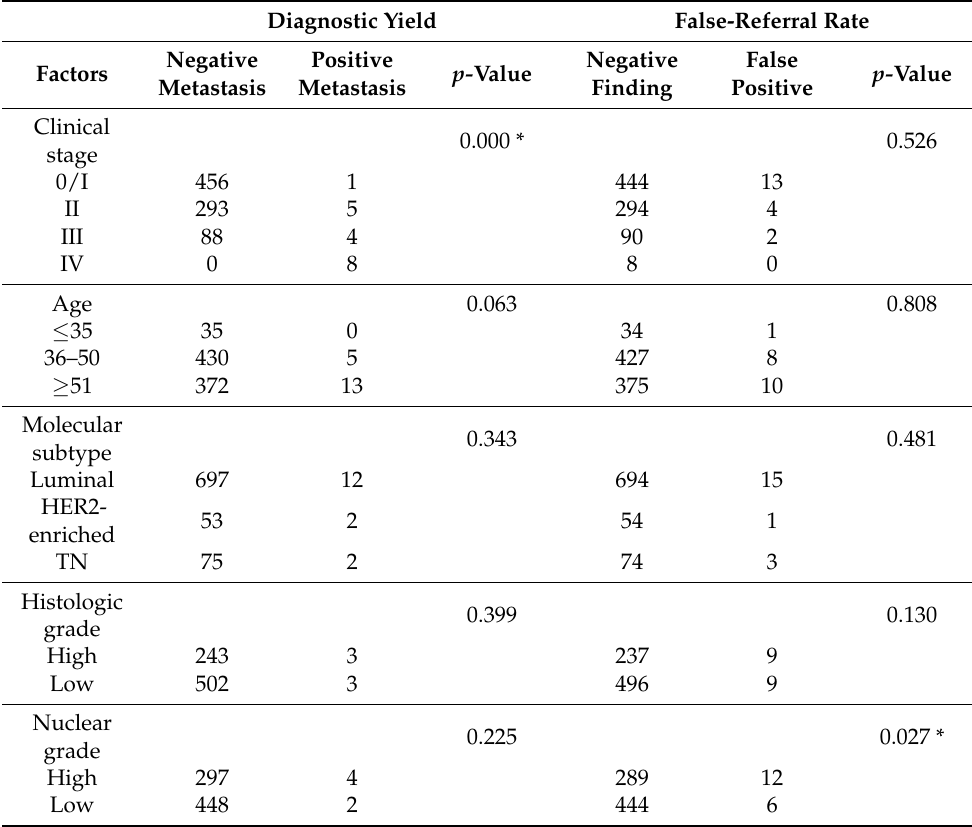
Table 6. Factors influencing diagnostic yield and false-referral